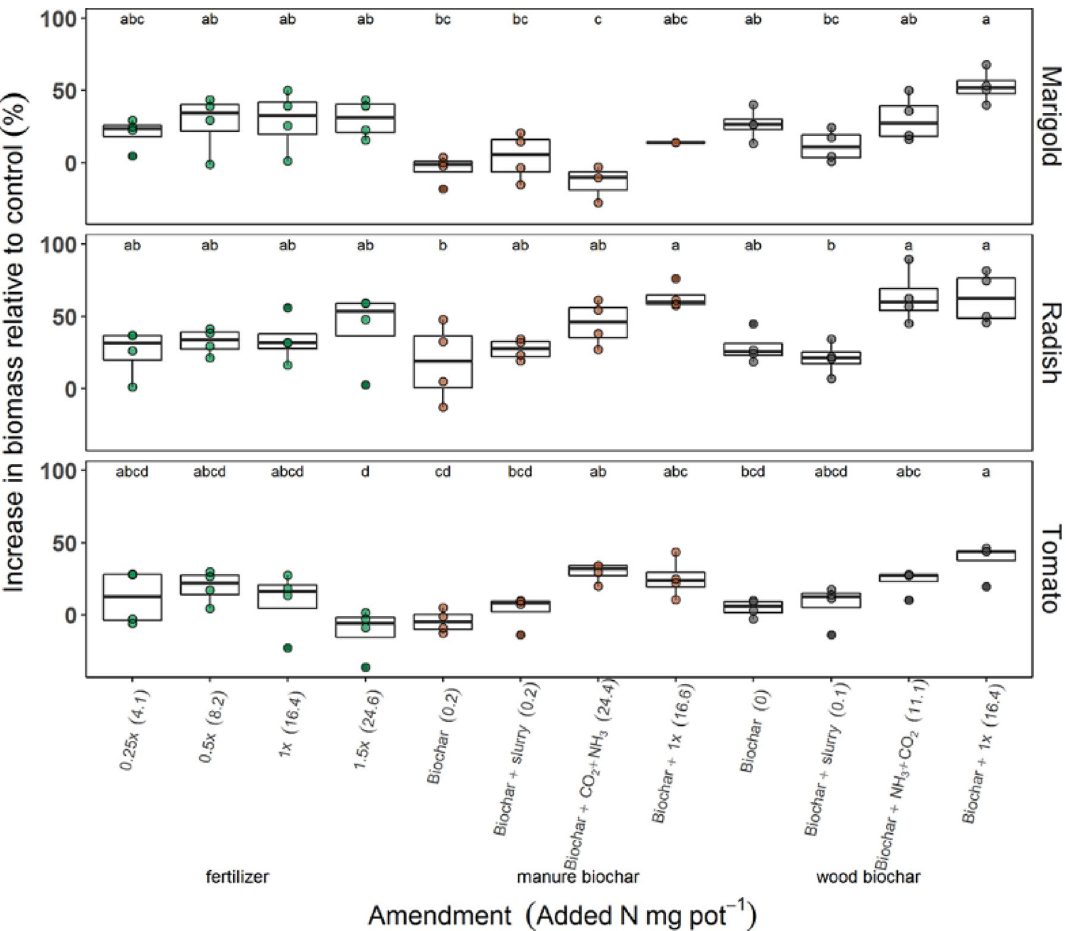
Figure 1. Increase in plant biomass (sum of root and shoot biomass) grown with urea fertilizer (green points), manure biochar (brown points) or wood biochar (gray points) amendments relative to unamended plants (0×). The amount of plant-available N in each type of amendment in parentheses. Letters above the bars indicate significant differences between amendments within plant type ( p < 0.05; n = 4; whiskers indicate standard